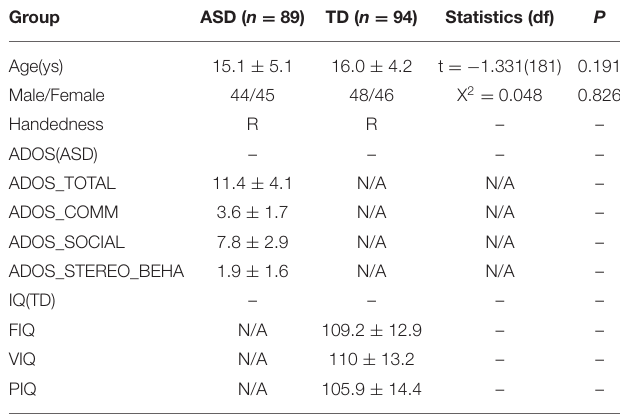
TABLE 4 | Demographic characteristics of